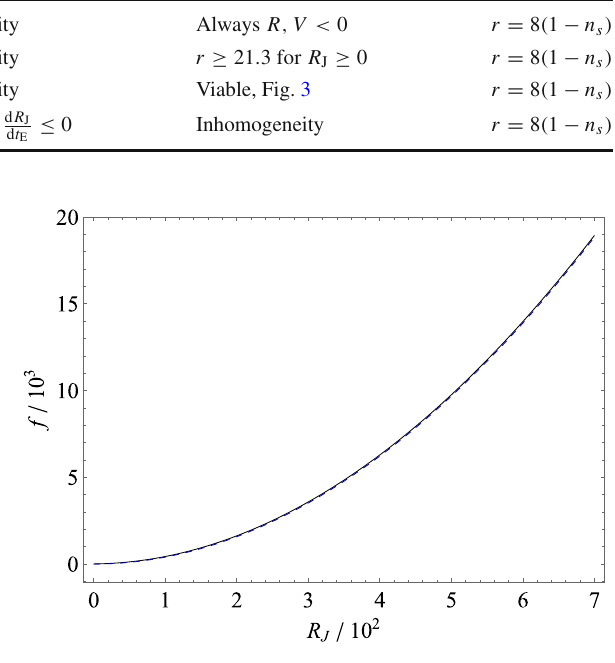
Fig. 2 The function f ( R J ) for β = − 0 . 02 ,γ = − 1 in the exact parametric form (26) ( black , solid ) and the approximated form (27) ( blue , dashed